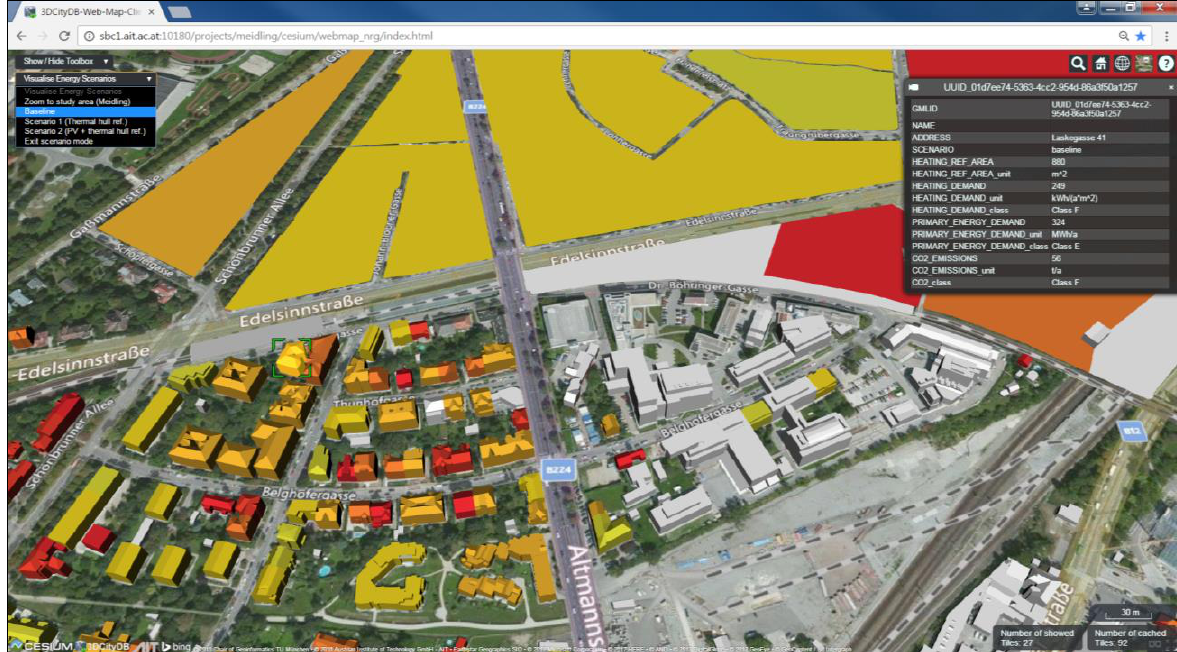
Figure 6. Example of hybrid (multi-scale) representation of the energy performance class of buildings and building blocks. The user can select among different scenarios in the upper-left drop-down menu and query buildings and blocks for thematic data